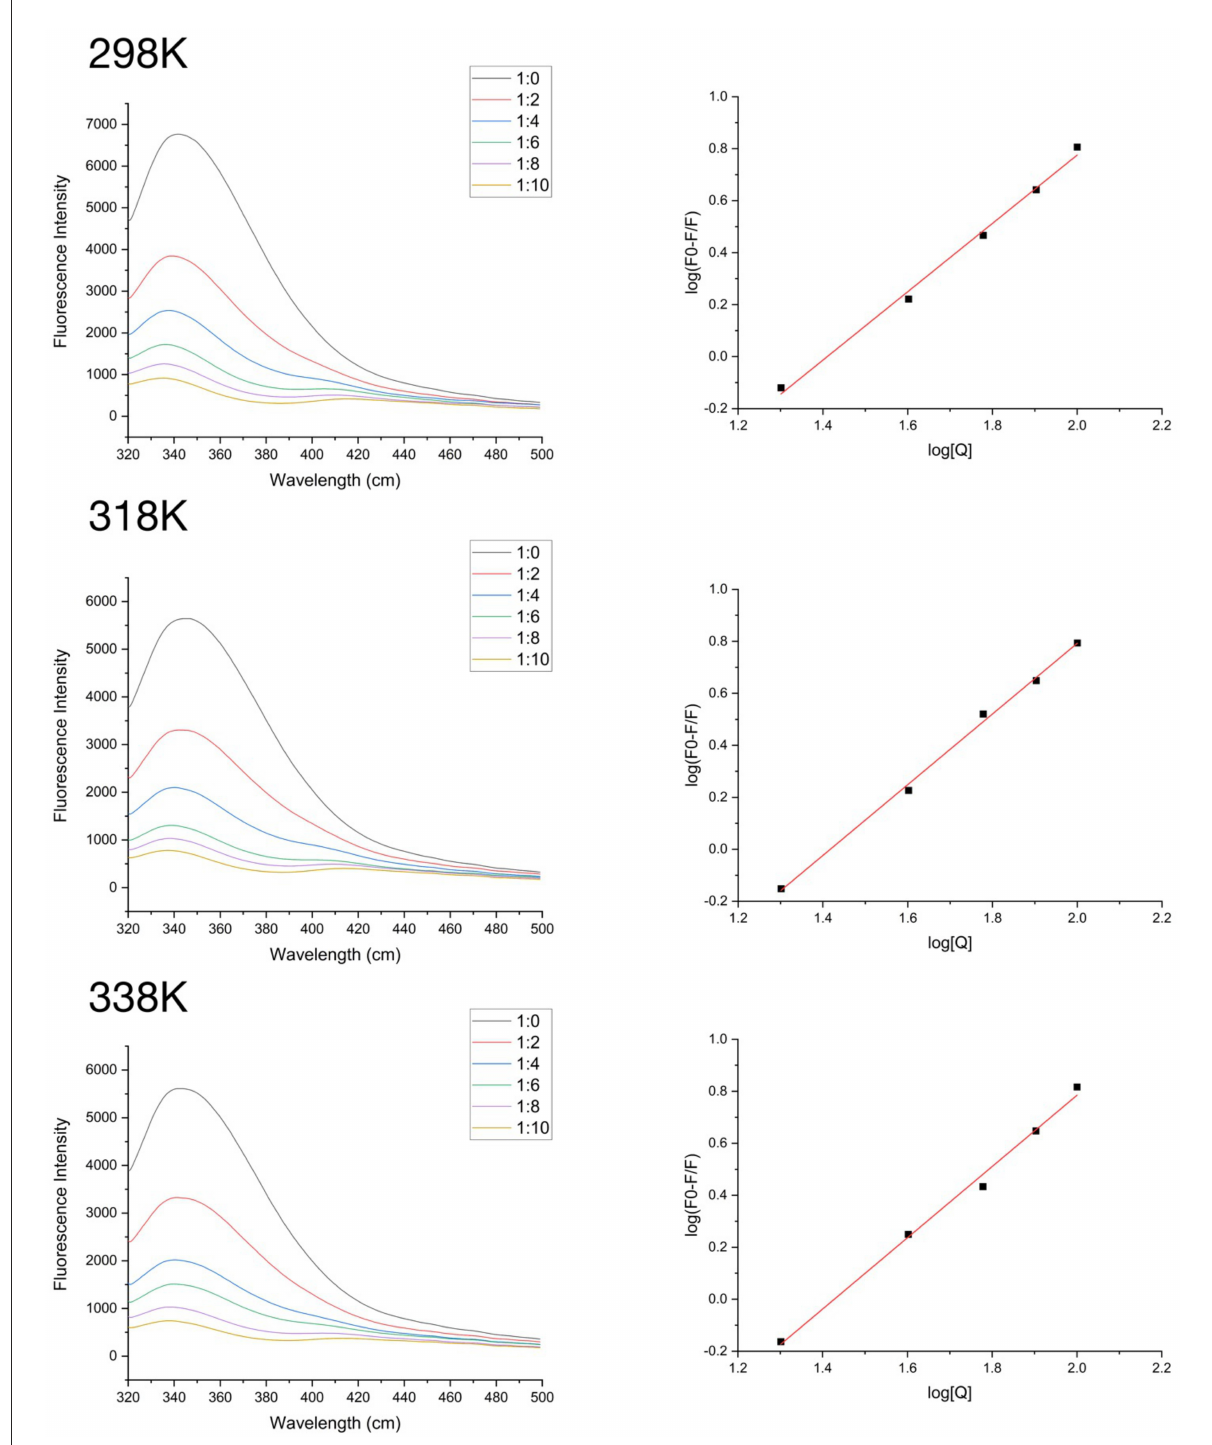
FIGURE2 At 298K, 318K, and 338K, the fluorescence intensity of SPI and quercetin (Que) complexes in the range of 320–500nm and the logarithmic equation fitting